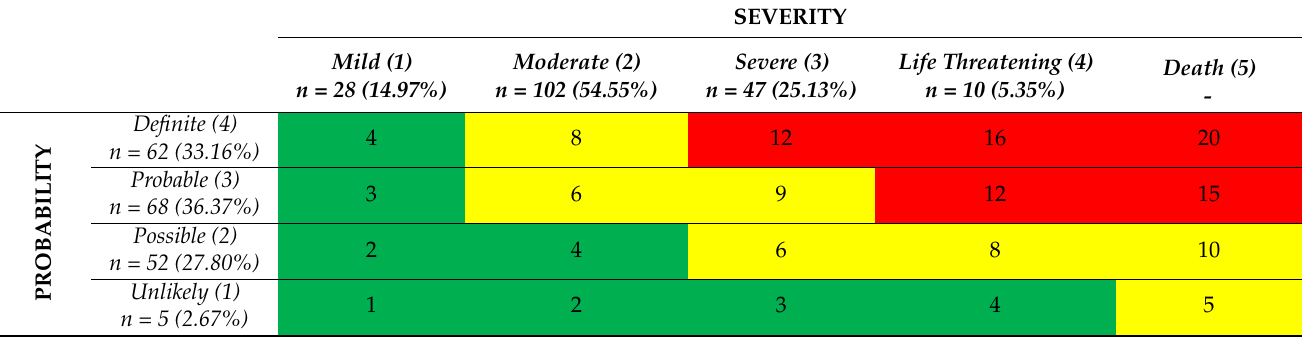
Table 2. Distribution of observed ADRs according to the probability and severity